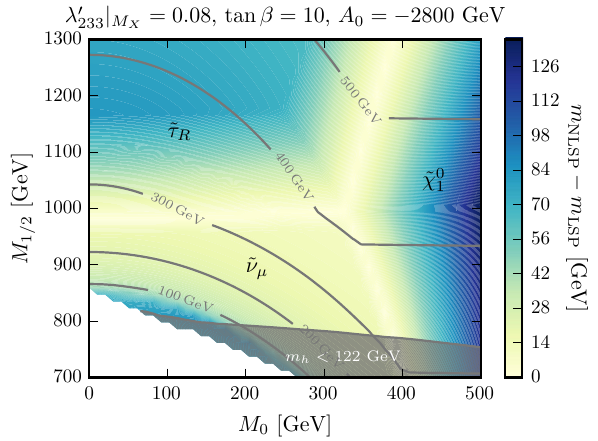
| = 0 . 5. The M X 212